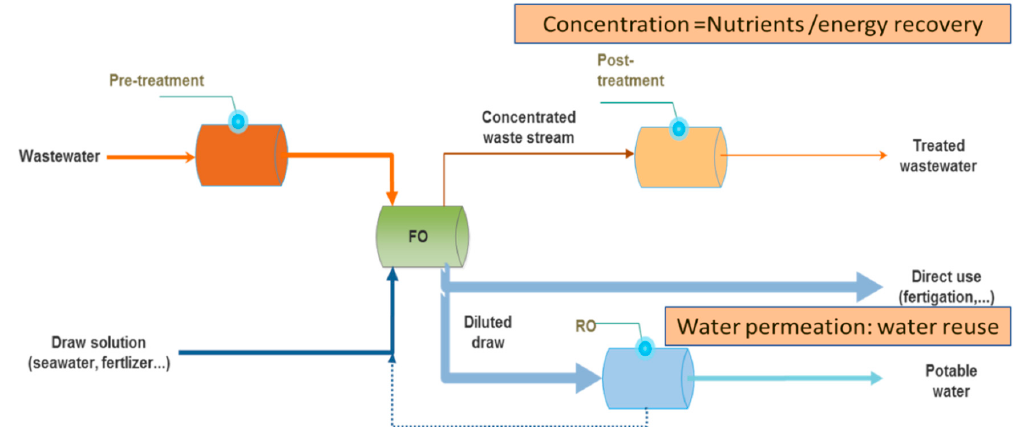
Figure 3. Integration of FO as a concentration process in the WW treatment line to combine water reuse and nutrients concentration.